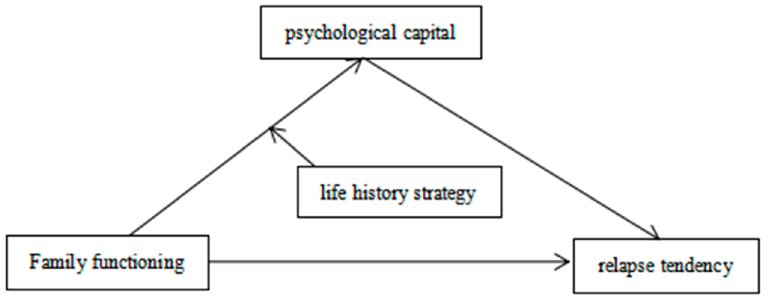
Figure 1. a hypothetical model of the effect of family functioning on relapse tendency. Figure 1. A hypothetical model of the effect of family functioning on relapse tendency.